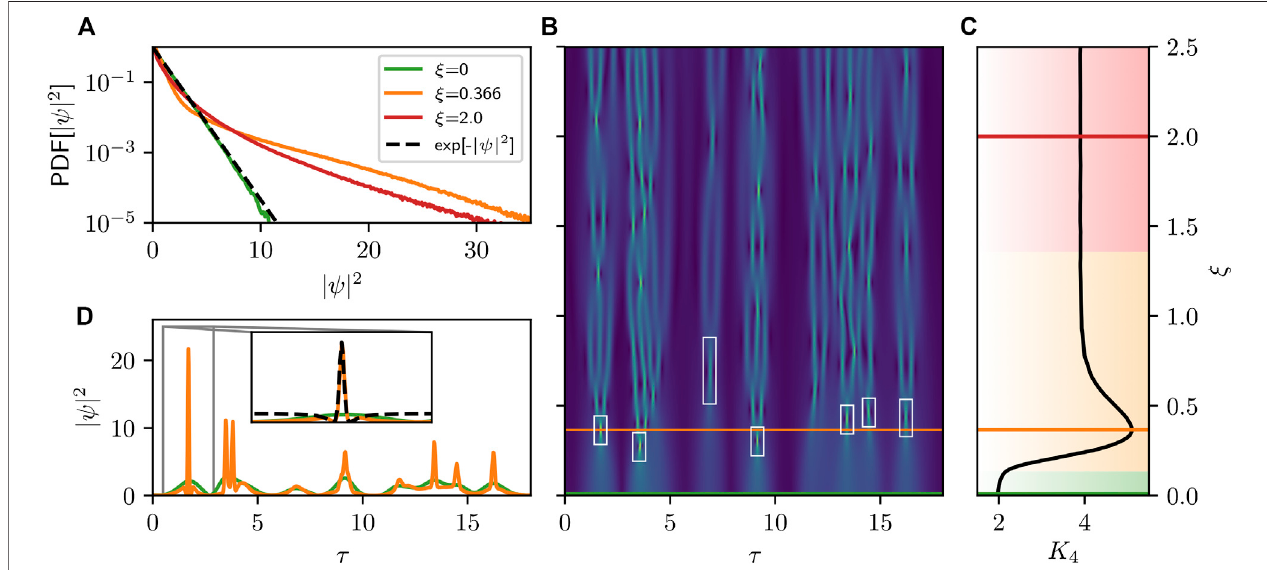
(cid:11)(cid:11)(cid:11)(cid:11) (cid:11)(cid:11)(cid:11)(cid:11) 2 at three different ψ (cid:11)(cid:11)(cid:11)(cid:11) (cid:11)(cid:11)(cid:11)(cid:11) (cid:11)(cid:11)(cid:11)(cid:11) ψ | 2 ) . (B) Spatiotemporal diagram of ψ . White boxes (cid:11)(cid:11)(cid:11)(cid:11) (cid:11)(cid:11)(cid:11)(cid:11) 2 pro fi leat twovaluesof ξ (cid:2) 0,0.366 (colorsarepreserved).Insetplot demonstrates a fi tof ψ